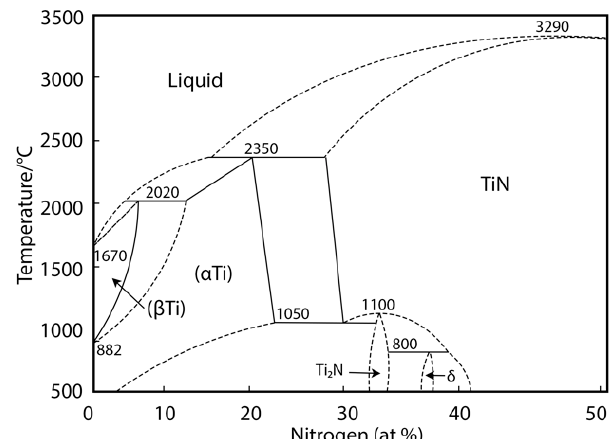
Figure 11. Ti–N phase diagram, 1 atm. pressure. Modified from [26–28].